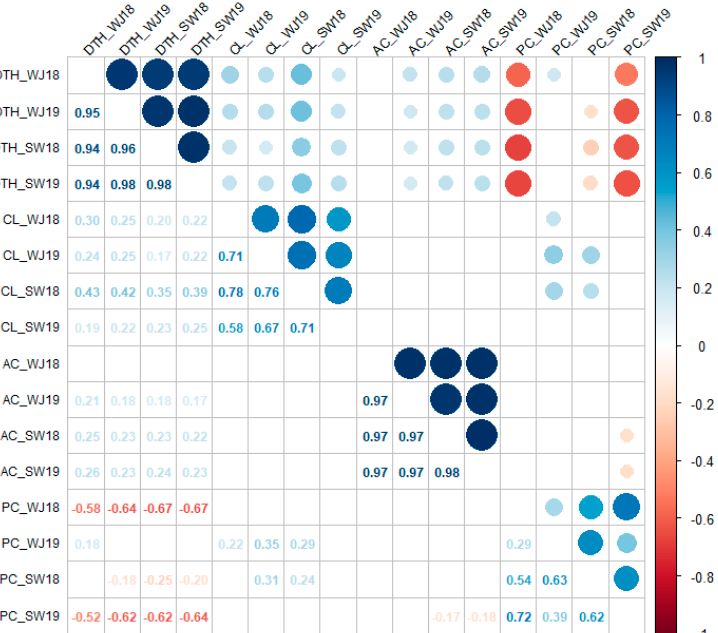
Figure 2. Correlations among days to heading (DTH), culm length (CL), amylose content (AC), and protein content (PC) of 293 Korean elite rice cultivars evaluated at two different locations (WJ—Wanju; SW—Suwon) in two years (2018 and 2019). Pearson’s correlation coefficients significant at p < 0.01 are shown in the lower matrix. The size and color thickness of each circle in the upper matrix are proportional to the relevant correlation coefficient.